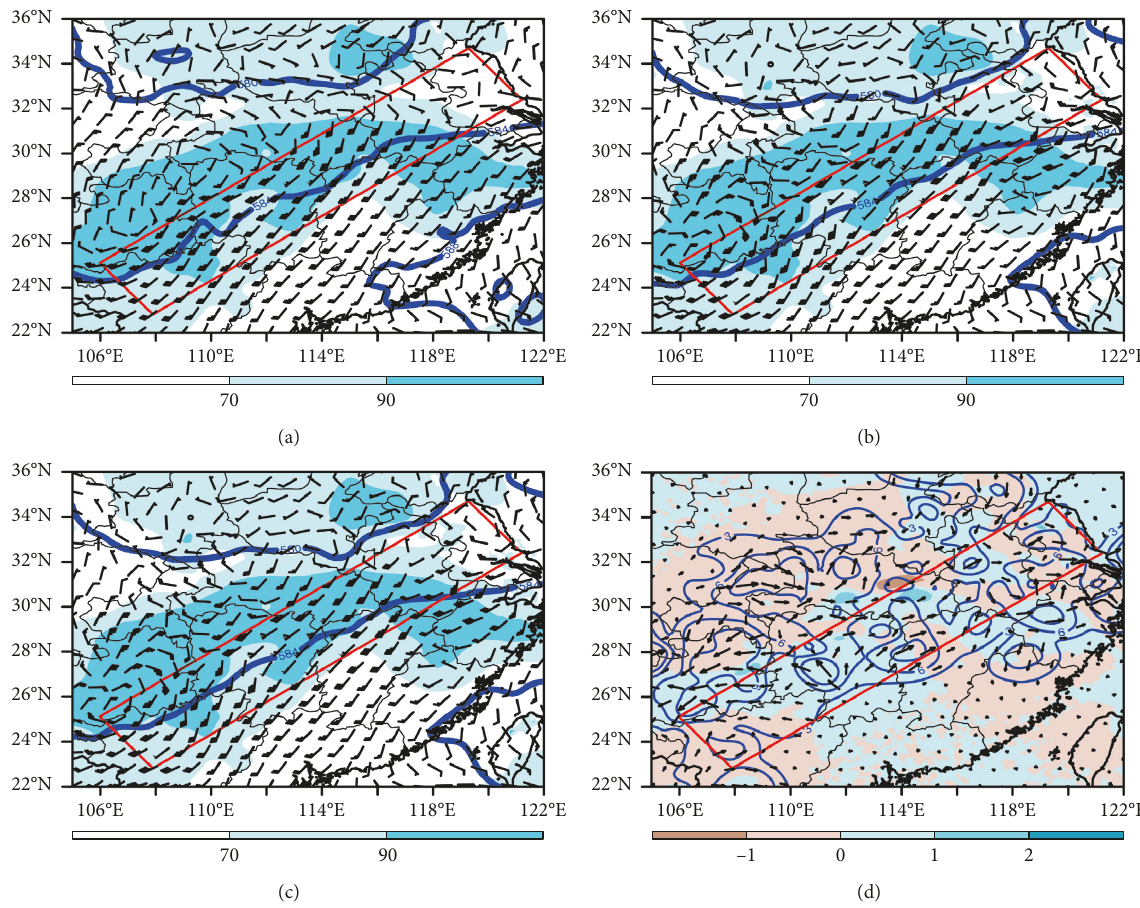
Figure 7: Wind (wind barbs) and relative humidity (shaded, unit: %) at 700 hPa and geopotential height (blue lines, unit:10 gpm) at 500 hPa ((a) CON, (b) RAD, (c) RADC) and wind increments between initial conditions for (d) RAD and CON (blue lines indicate wind velocity, unit: m/s) and specific humidity increment between RADC and RAD (shaded in (d), unit: g/kg) at